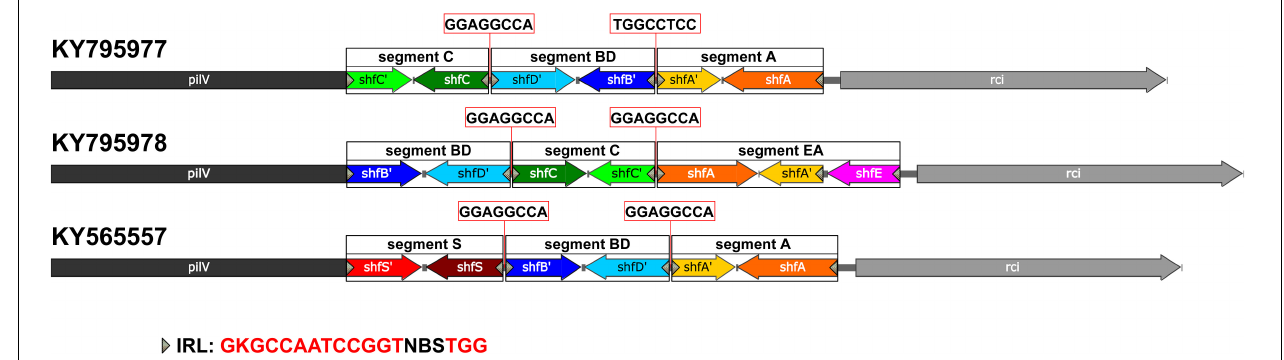
FIGURE 3 | Typical shufflon structures in three representative IncI2 plasmids. Accession numbers is listed beside. The common inverted repeat sequence in shufflon segments is shown at the bottom as IRL. The highly conserved repeat (inverted or direct repeat) sequences between adjacent shufflon segments are shown in red